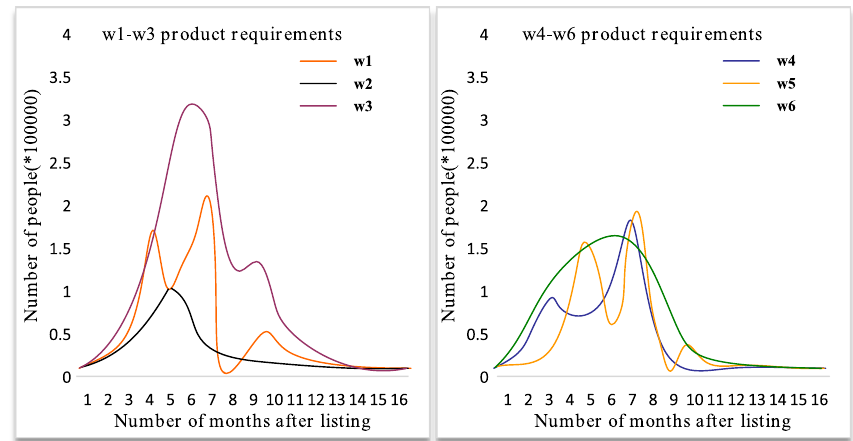
Fig. 8 Product demand data